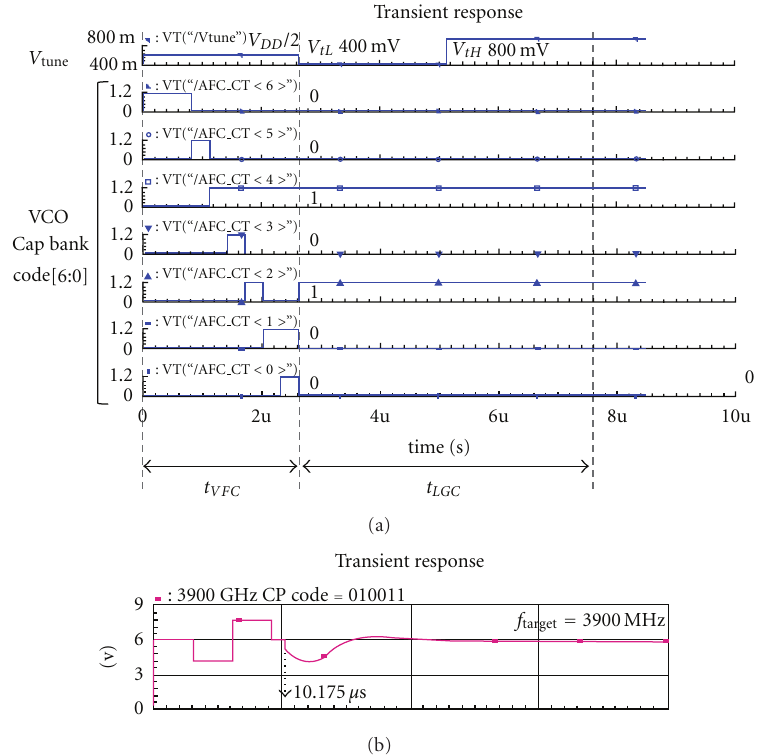
Figure 14: Behavioral simulation results for the proposed autocalibration. (a) V tune and VCO cap bank code during autocalibration. (b) V tune for the total locking process for 3900 MHz target frequency.